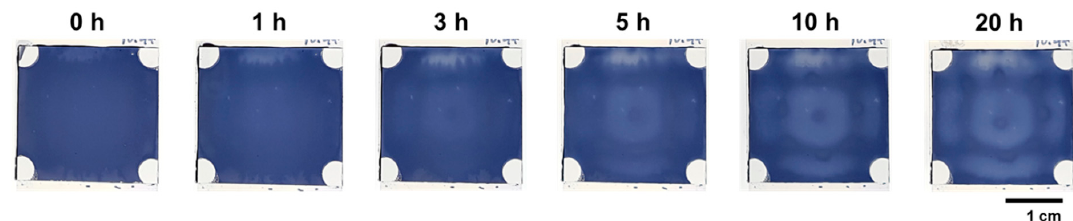
Figure 2. Photographs of the fabricated LC cell in the opaque state. They were taken by placing it on top of a white backlight.